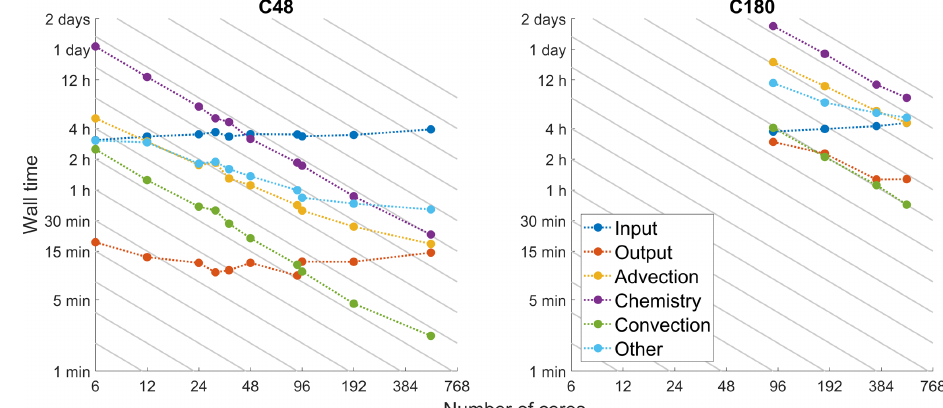
Figure 4. Total wall time per component for low (C48) and high (C180) resolution simulations. Simulations at C180 are limited to core counts of 90 or more across several nodes for the hardware used here, due to the high memory requirements of such high-resolution simulations.